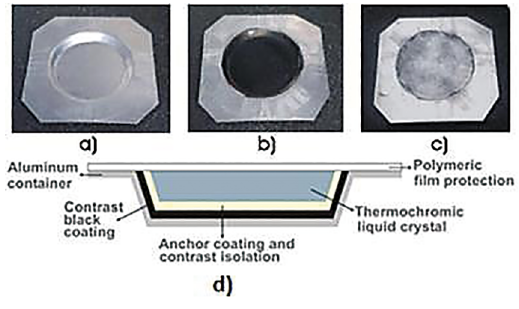
Figure 1. Photographs showing the assembly of the temperature sensor prototype: (a) empty cavity, (b) cavity with black background, and (c) LC at room temperature. (d) Schematic of the temperature sensor prototype (central longitudinal cross